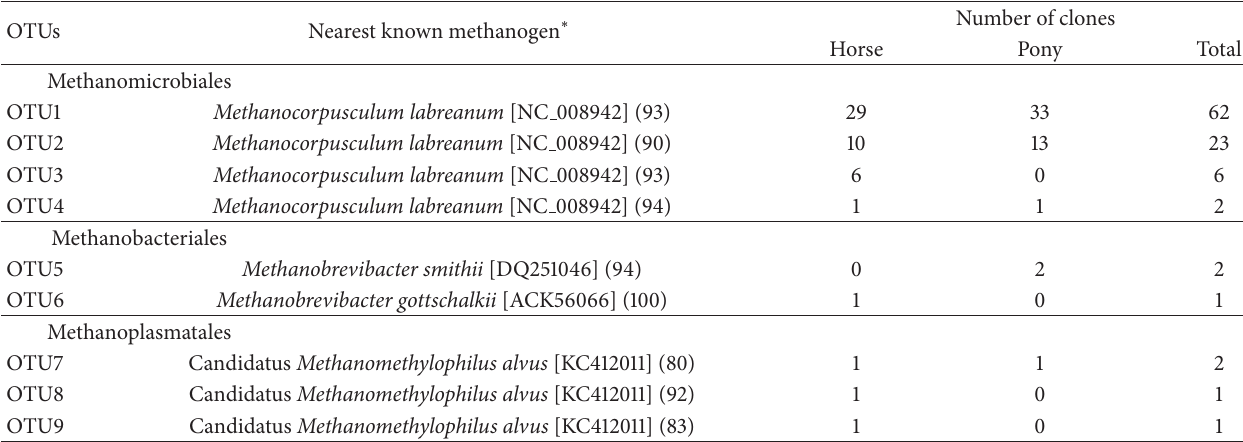
Table 3: The number of clones and similarity of the deduced amino acid sequences of the mcrA gene of each operational taxonomic unit (OTU) to cultured methanogens in horse and pony.